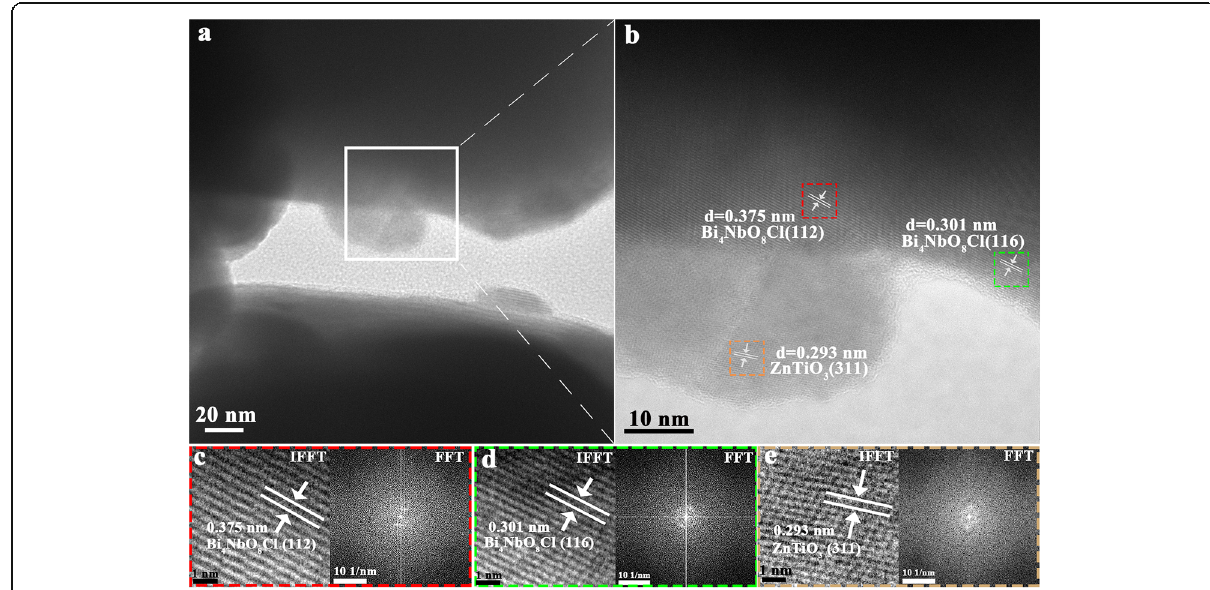
Fig. 2 a , b TEM and HRTEM images of 20% BNZ; c IFFT and FFT images of Bi 4 NbO 8 Cl (112) crystal planes; d IFFT and FFT images of Bi 4 NbO 8 Cl (116) crystal planes; e IFFT and FFT images of ZnTiO 3 (311) crystal